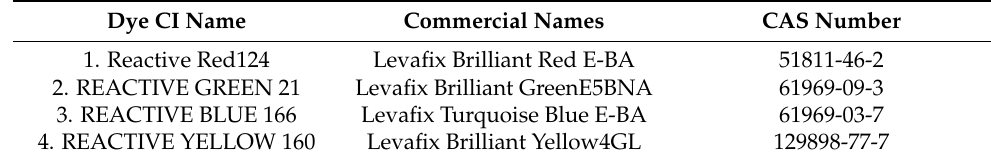
Table 1. Dyes used for samples.